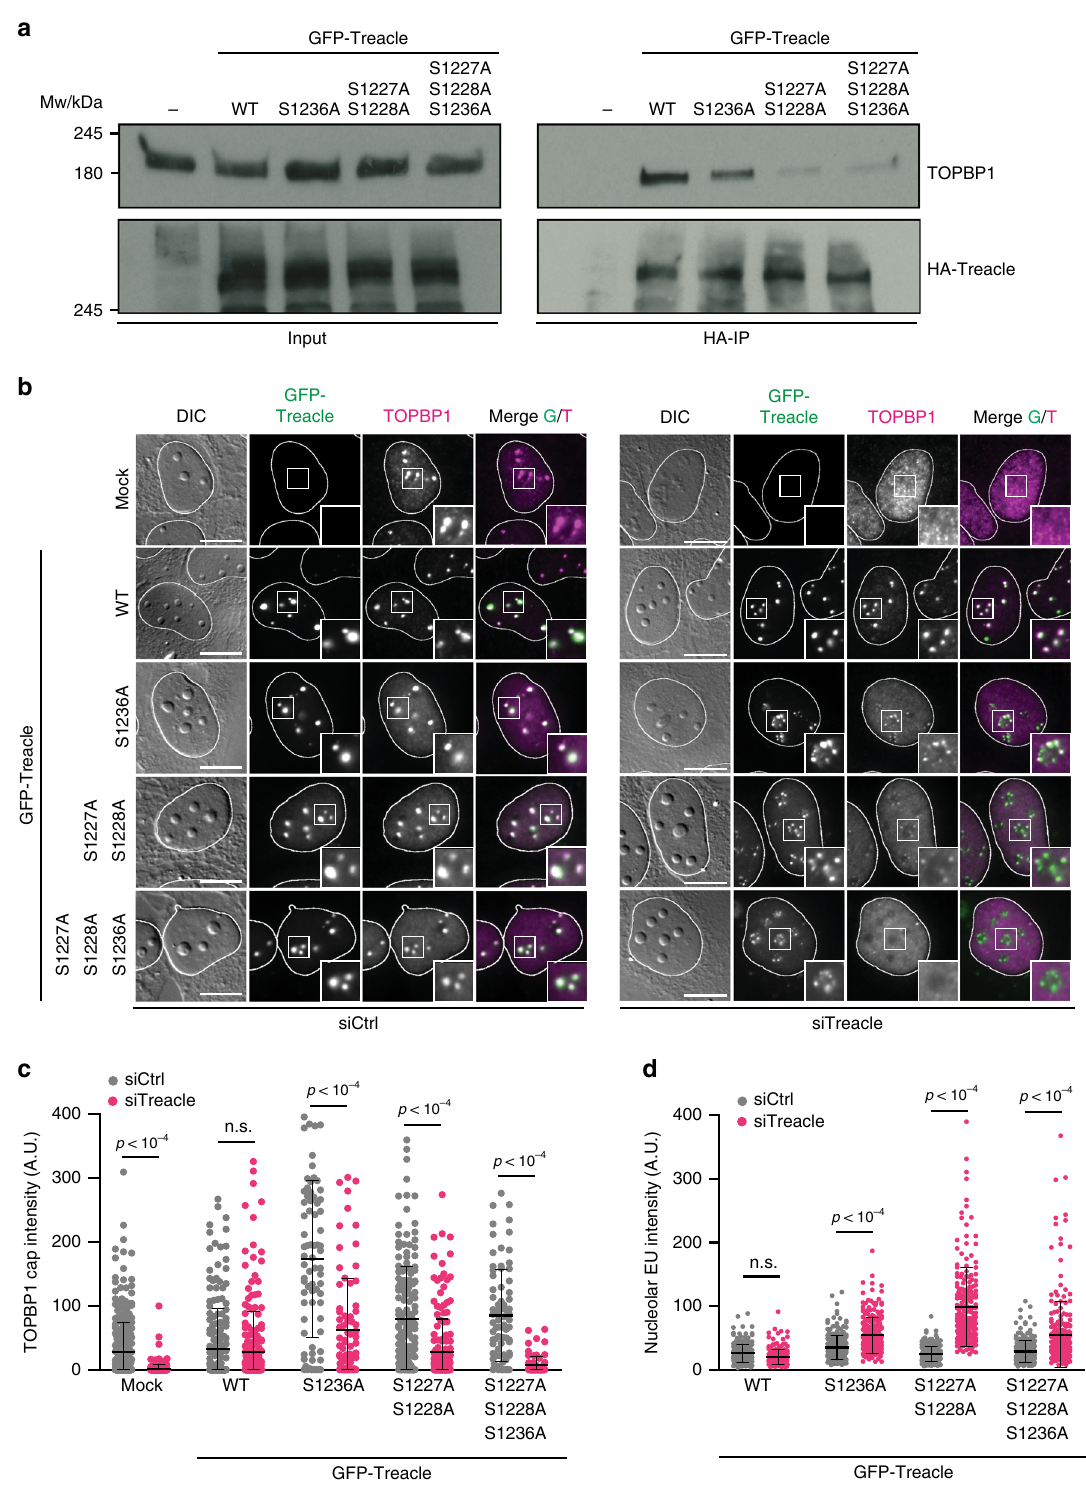
vation of these kinases at sites of rDNA breaks occurs indepen- dently of Treacle. Second, TOPBP1 recruitment in the nucleoli occurs independently of ATR in a subset of cells, and third, overexpression of TOPBP1 leads to ATR-dependent transcrip- tional repression in the nucleoli followed by nucleolar segregation even in the absence of rDNA breaks 28